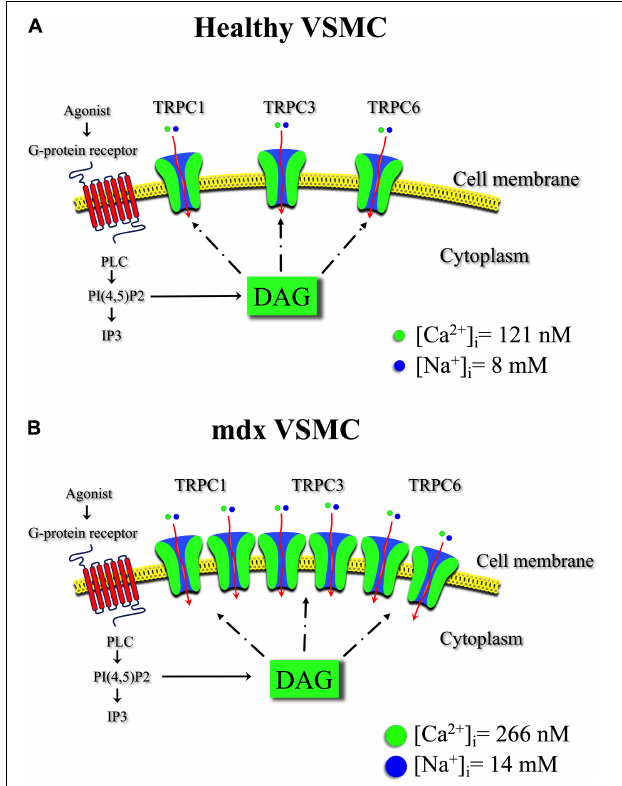
FIGURE 11 | Transient receptor potential canonical channel in healthy and mdx VSMCs. Schematic representation of TRPC channels isoforms and the effect of diacylglycerol (DAG) on intracellular [Ca 2 + ] and [Na + ] in healthy (A) and in mdx VSMC (B) . Binding of the agonist to the G-protein-coupled receptor leads to phospholipase C (PLC) activation. The activation of PLC hydrolyzes phosphatidyl 4-5 biphosphate PI(4,5)P2 to produce diacylglycerol (DAG) and IP3. DAG contributes to TRPC3 and TRPC6 channels, but also TRPC1 activation under heteromeric complexes allowing Ca 2 + and Na + influx into the vascular muscle cell. A chronic increase in Ca 2 + and Na + flux through the upregulated TRPC channels in mdx VSMCs contribute to the observed elevate [Ca 2 + ] i and [Na + ] i